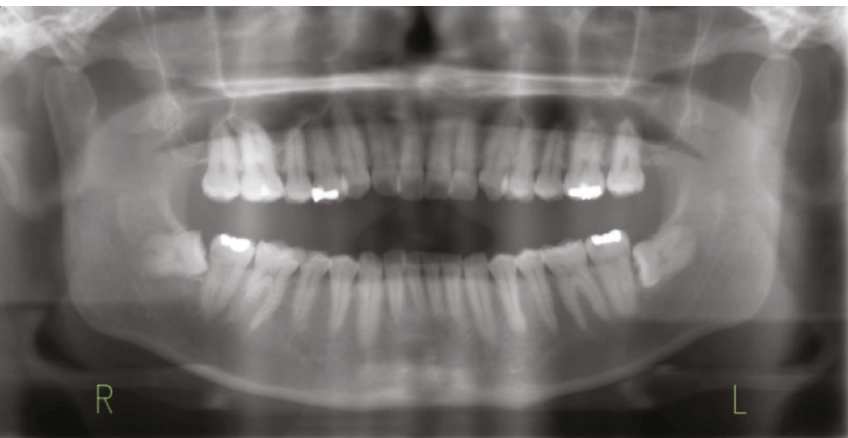
Figure 1: A panoramic radiograph obtained before the extraction. The radiograph shows that the right lower third molar was horizontal (Pell and Gregory Class I, position A). There are no prior bone lesions associated with the molar, such as cyst and tumor.